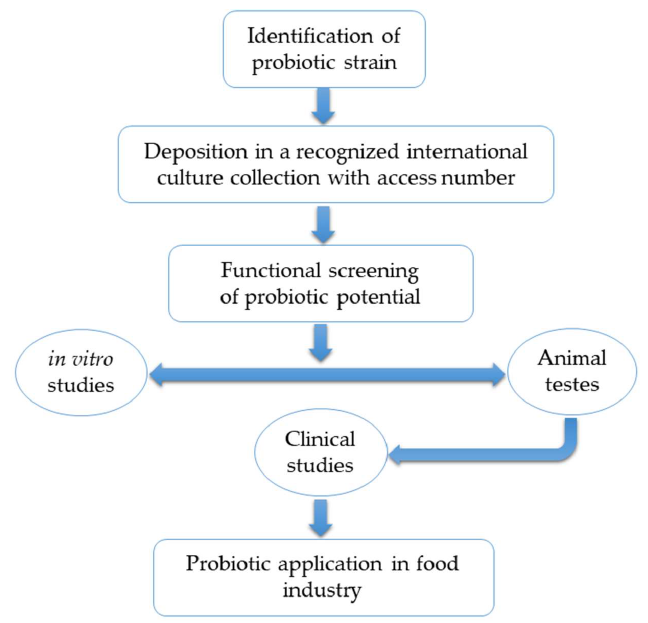
Figure 1. Basic steps for functional probiotic food development.